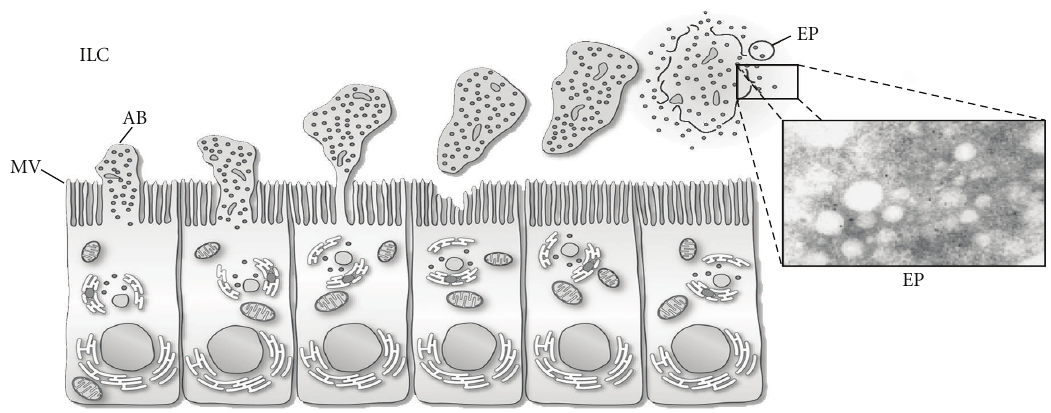
Figure 2: Schematic representation of apocrine secretion in principal cells of the epididymis. The inset shows electron micrograph of epididymosomes. AB, apical bleb; EP, epididymosomes; ILC, intraluminal compartment; MV, microvilli. Reproduced from [32] with permission of the